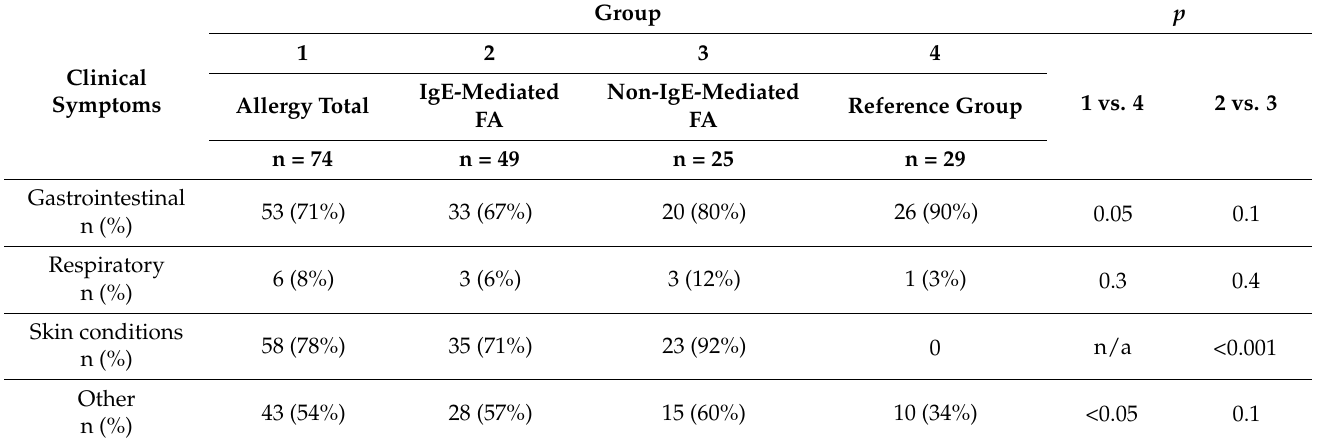
Table 1. Incidence of analysed systemic symptoms in different